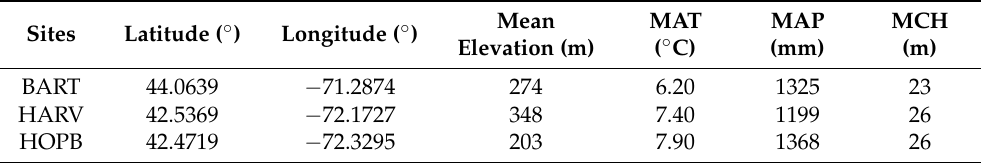
Table 1. Geographic characteristics of the BART, HOPB, and HARV sites. The abbreviations of MAT, MAP, and MCH refer to mean annual temperature, mean annual precipitation, and mean canopy height,